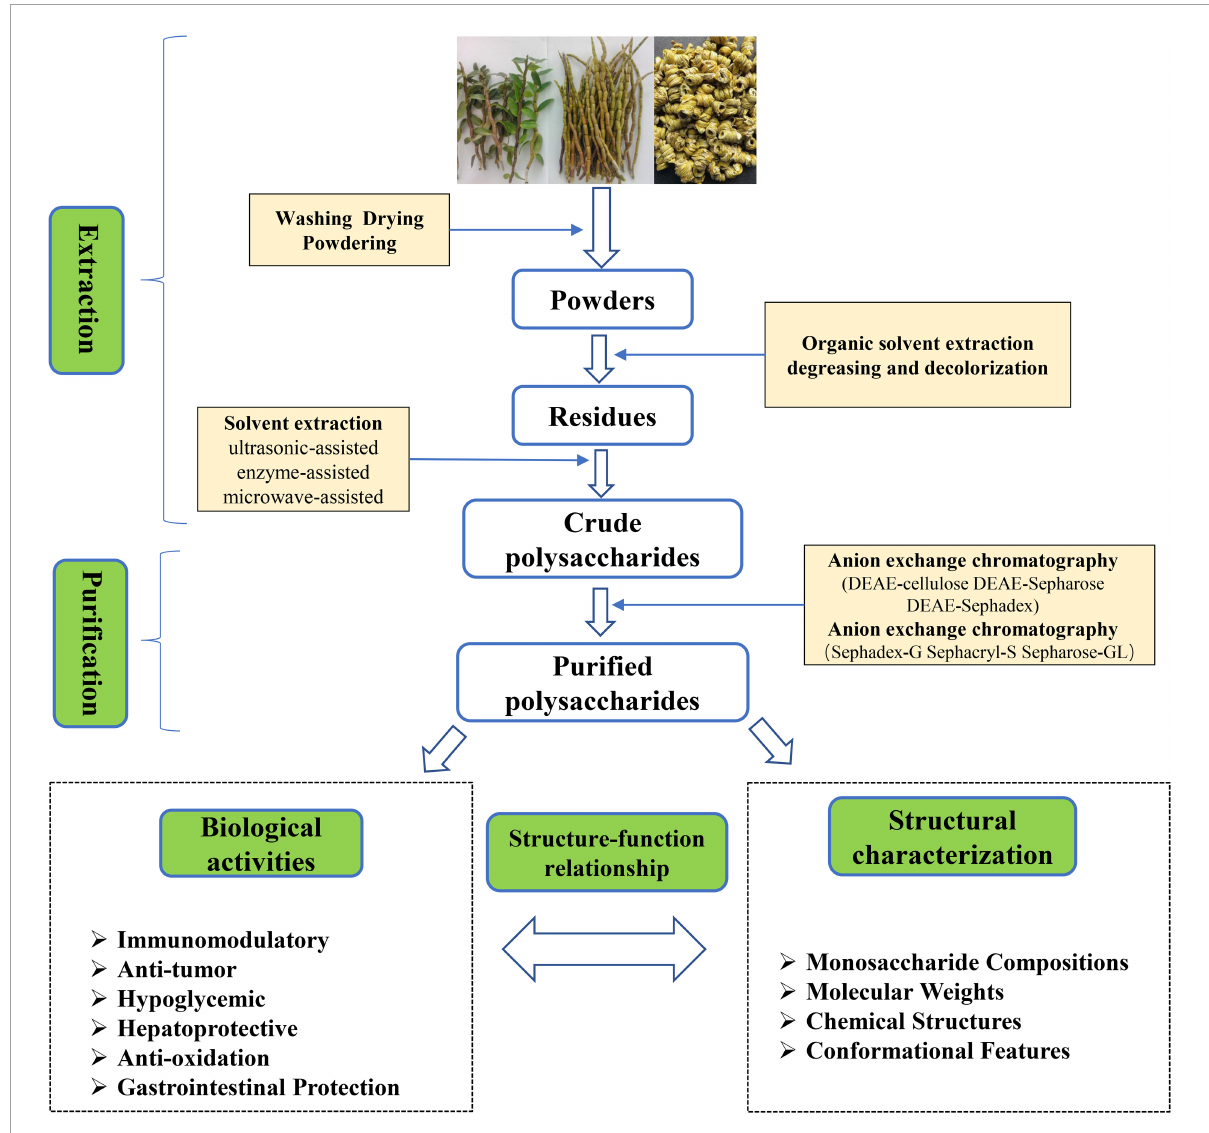
FIGURE1 Schematic representation of the extraction, purification, and bioactivity of polysaccharides from Dendrobium officinale